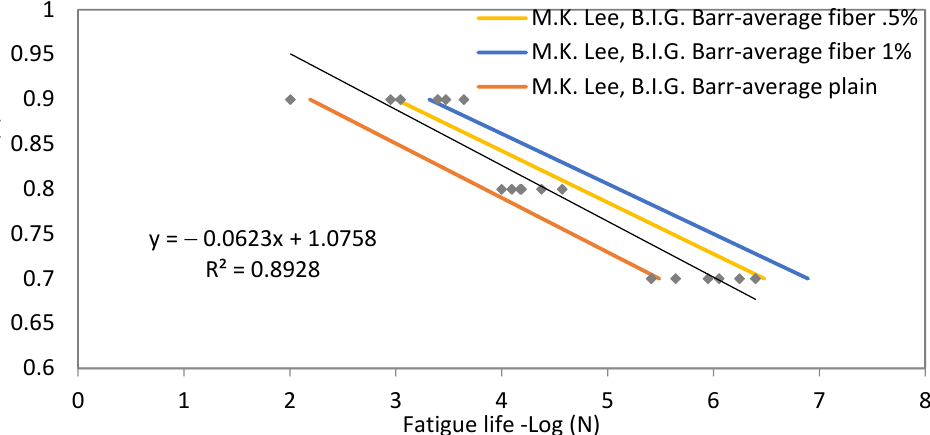
Figure 8. Validation of fatigue results with respect to the average results of several studies [64].